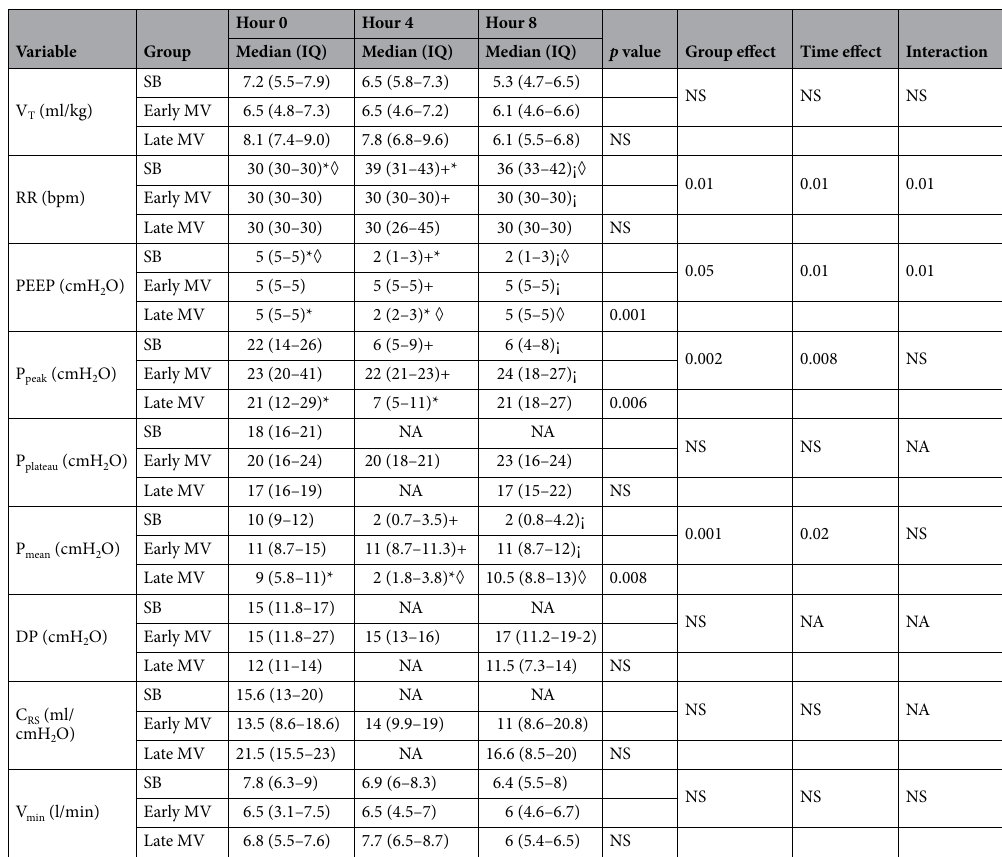
Table 3. Ventilatory parameters. p value corresponds to Friedman test to the Late MV group, (* and ◊) correspond to p < 0.05 for Dunn`s multiple comparisons test. The interaction, group effect, and time effect were estimated between SB and Early MV groups, using the GLMM for each variable. Posthoc analysis was done using the Tukey test. The uppercases * and ◊, denote p < 0.05 in pairwise comparisons for time within each group. The “+” and “¡” signs denote p < 0.05 in pairwise comparisons between groups. MV: mechanical ventilation, SB: spontaneous breathing, VT: tidal volume, RR: respiratory rate, PEEP: positive end-expiratory pressure, Ppeak: peak pressure, Pplateau: plateau pressure, Pmean: mean pressure, DP: driving pressure, CRS: respiratory system compliance, Vmin: minute volume.